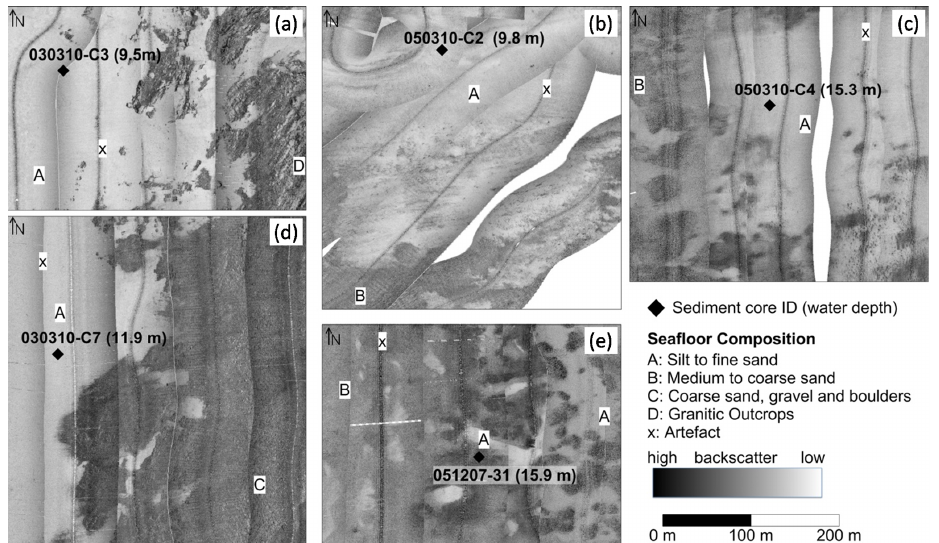
Figure 3. Cutouts of the side-scan sonar mosaic showing the sediment distribution at the coring positions. No data are available for core 030310-C2. The composition of the seafloor was established based on the ground-truthing of the backscatter data with grab samples and underwater video images (Feldens et al.,